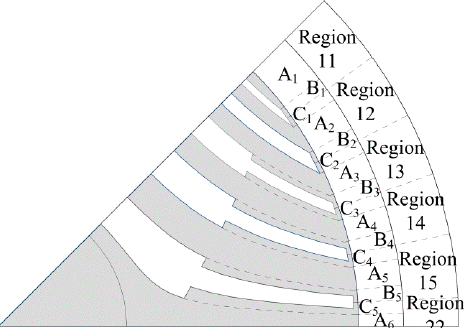
Figure 6. Detailed partition diagram of air-gap between stator and rotor of one-eighth motor.